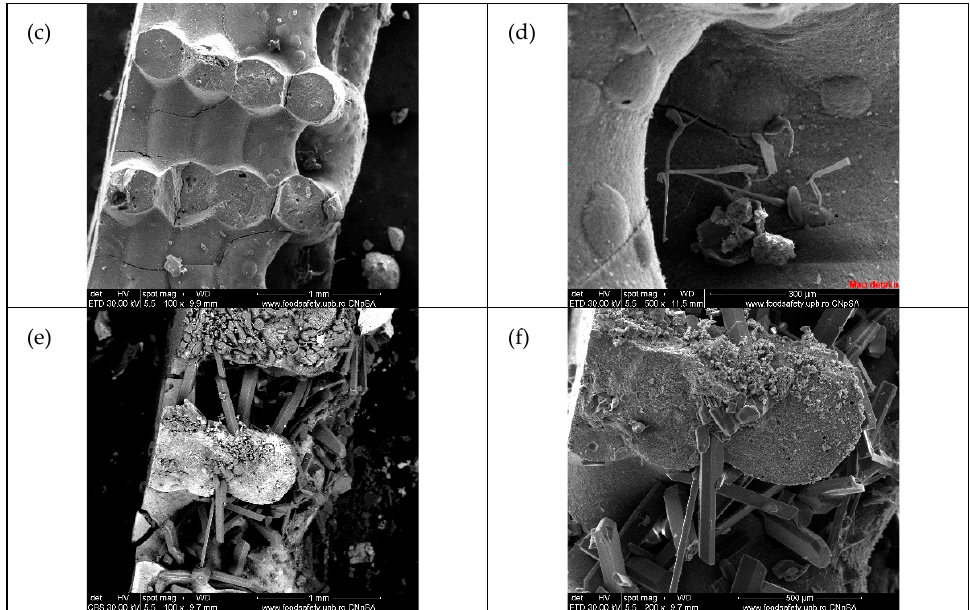
Figure 6. SEM cross-section images of ZnO-CNT-based 3D support structure impregnated with PCMs salts: ( a , b ) NaNO 3, ( c , d ) KNO 3 and ( e , f ) NaNO 3 :KNO 3 .